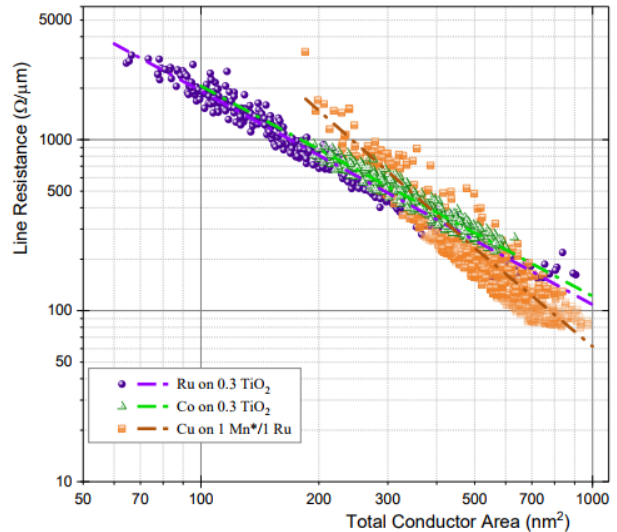
Figure 10. Logarithmic comparison of the damascene line resistance versus the total conductor cross-sectional area for Ru, Co, and Cu nanowires as determined using the TCR. The dotted lines are used to highlight the general trend. Reprinted/adapted with permission from Ref. [84]. 2018, IEEE.